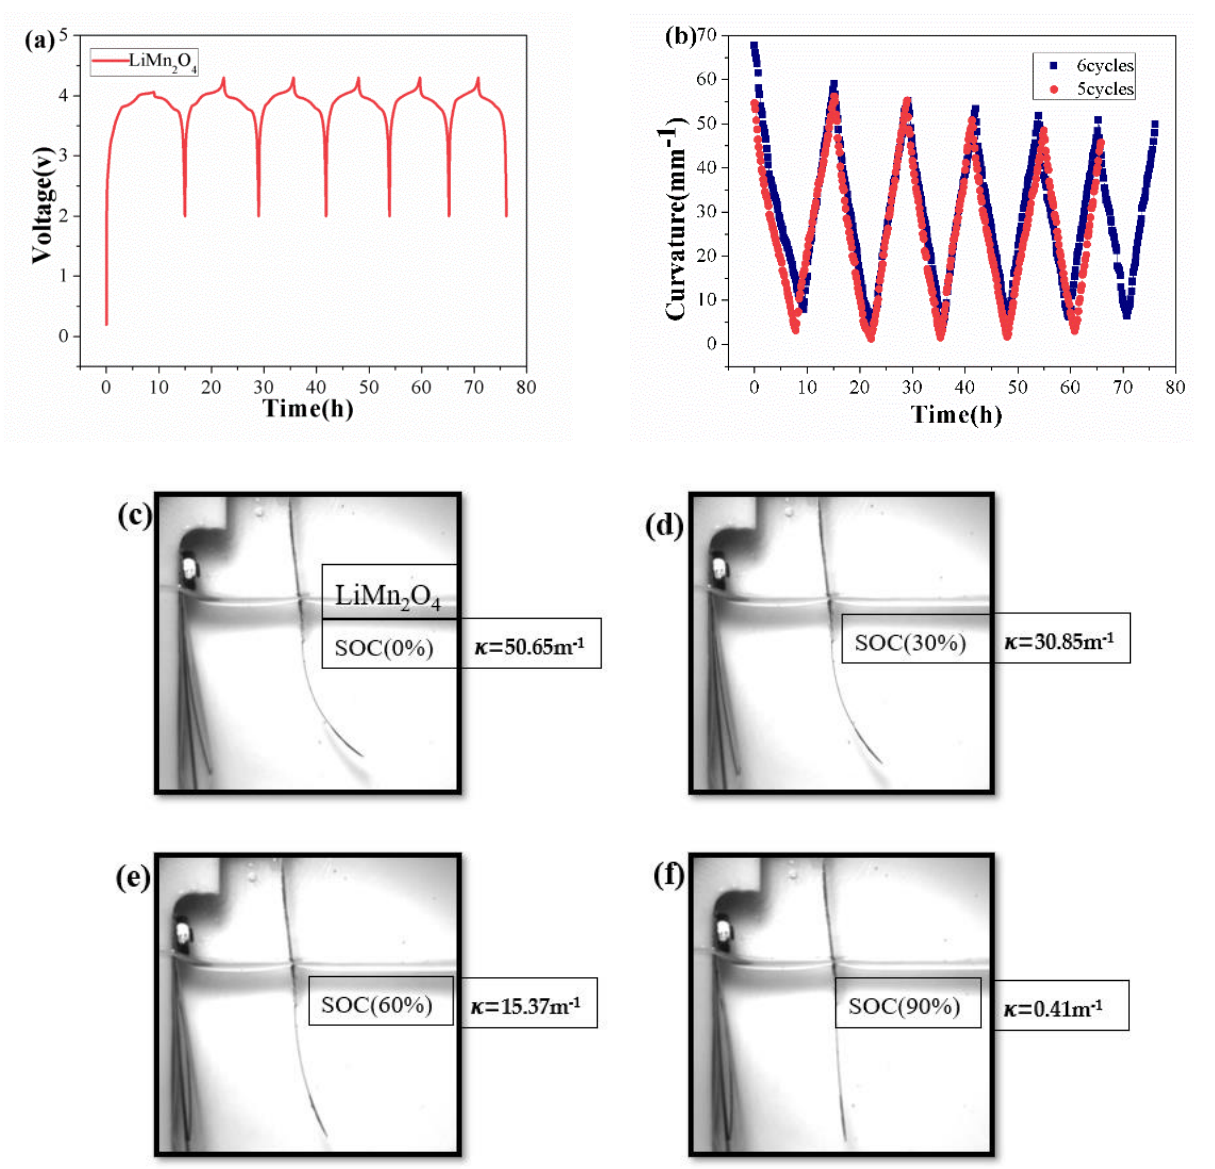
Figure 4. ( a ) Voltage and ( b ) curvature evolution of the LiMn 2 O 4 composite electrode during the electrochemical cycles. The captured images of the bilayer beam electrode in the initial state ( c ) and working state ( d – f